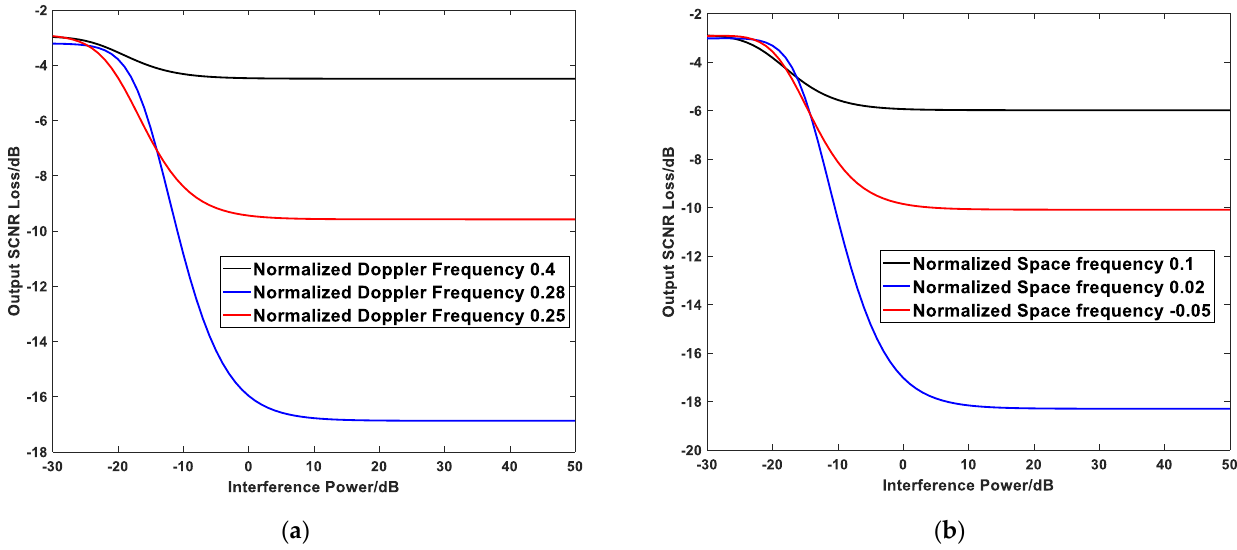
Figure 4. Effects of the outlier on output SCNR losses in training samples. They should be listed as: ( a ) Output SCNR losses at different normalized Doppler frequencies; ( b )Output SCNR losses at different normalized space frequencies. Table 1. Radar system simulation parameters.